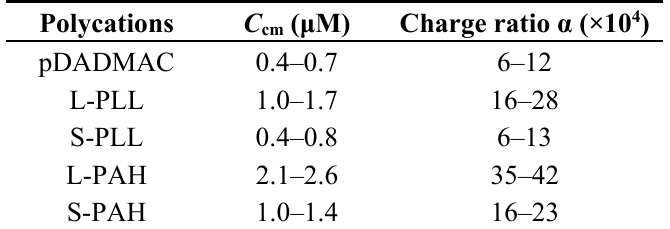
Table 2. The critical monomer-concentrations of the various polycations added for overcharging, and the charge ratio at the charge